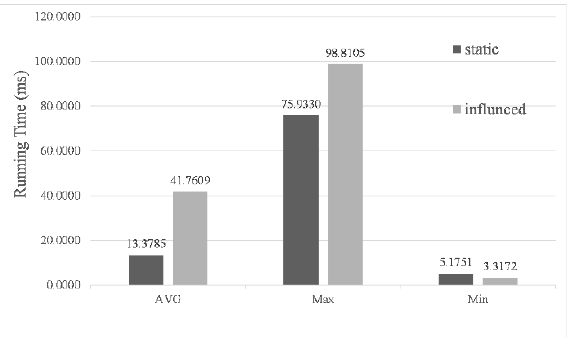
Figure 12. Program calculates time per statistical cycle analysis.